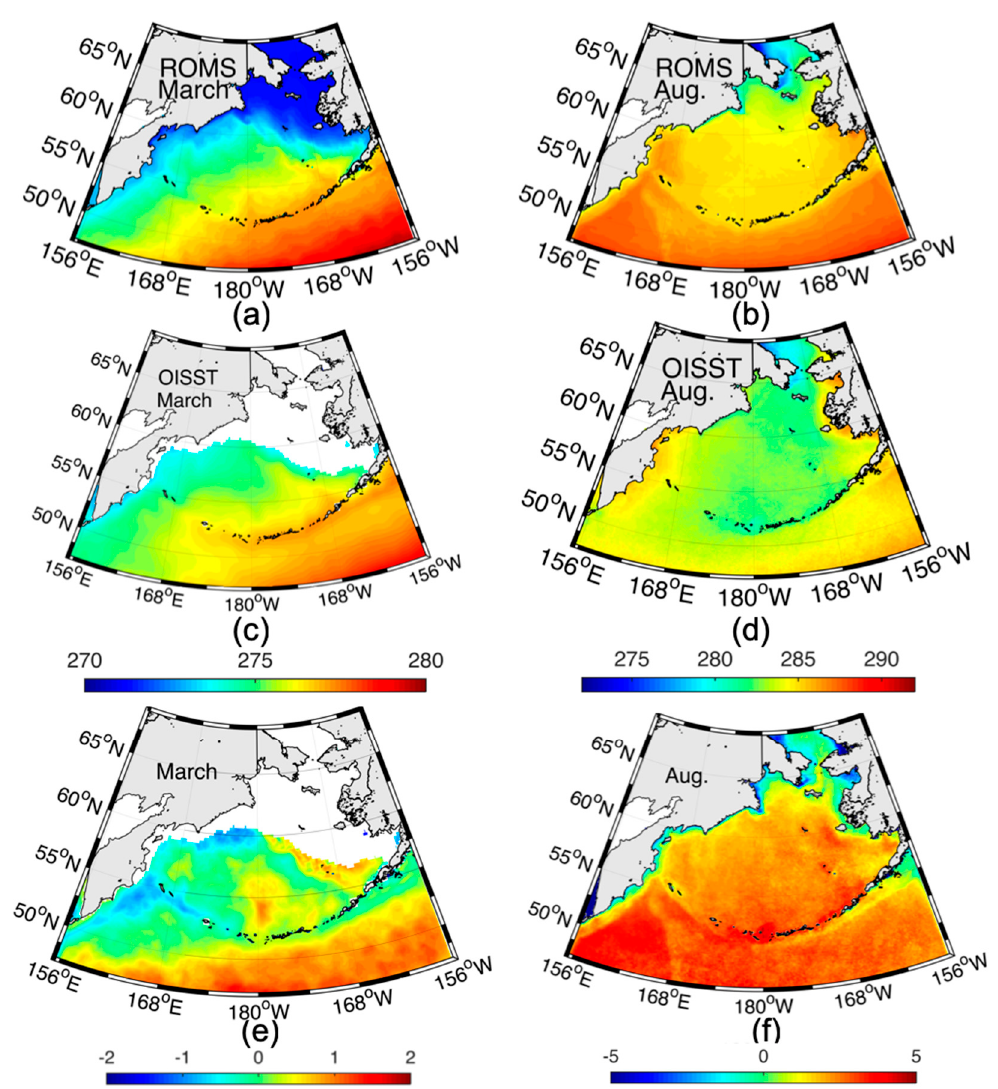
Figure 4. Seasonal variation in the SST in the Bering Sea: ( a ) March and ( b ) August, derived from the ROMS solution; ( c ) March and ( d ) August, derived from the AVHRR data. Also shown are the differences (ROMS minus OISST(OISST stands for “Optimum Interpolation Sea Surface